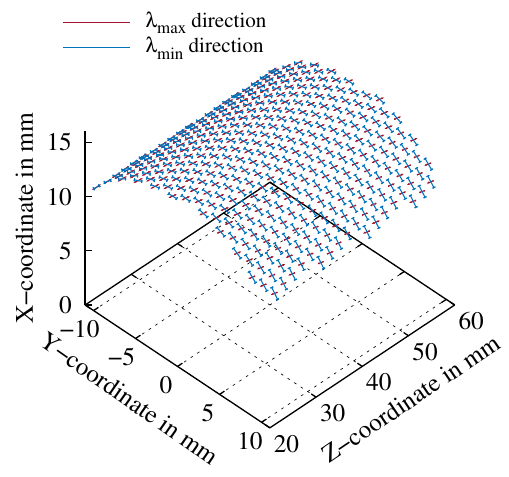
Figure 4. Principal directions (cid:126) u α , α = 1,2, of the in-plane right stretch tensor ˆ U for the torsional example ( ∆ d = 0.25mm for inverse multi-quadrics with monomials c I R 0 =